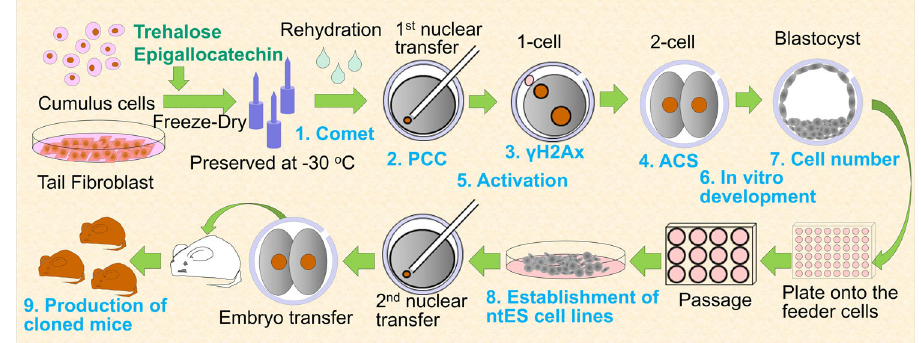
Fig. 1 Schematic diagram of the present study. Schematic showing the procedure for production of cloned mice from FD somatic cells. The FD somatic cells were preserved at – 30 o C up to 9